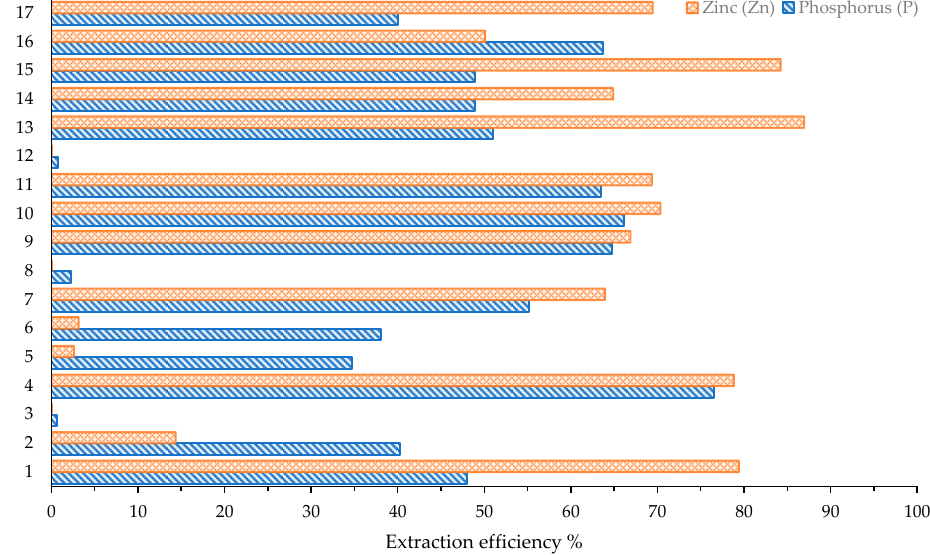
Figure 3. Extraction efficiency for phosphorus (P) and zinc (Zn), obtained from the results of colorimetric and TXRF analysis of the acid leachates.